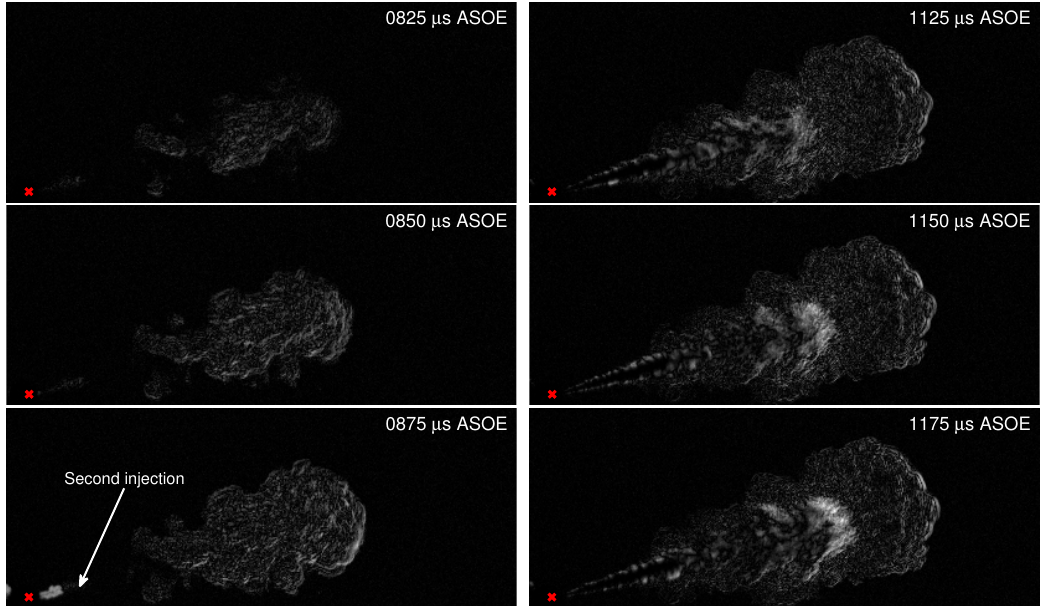
Figure 6. Example of absolute pixel-wise frame-to-frame differentiation for multiple injection. The frames shown are for a 1–29 pilot-main event with a dwell time of 350 µ s, a rail pressure of 100 MPa, a chamber density of 22.8 kg · m − 3 , and temperature of 900 K.